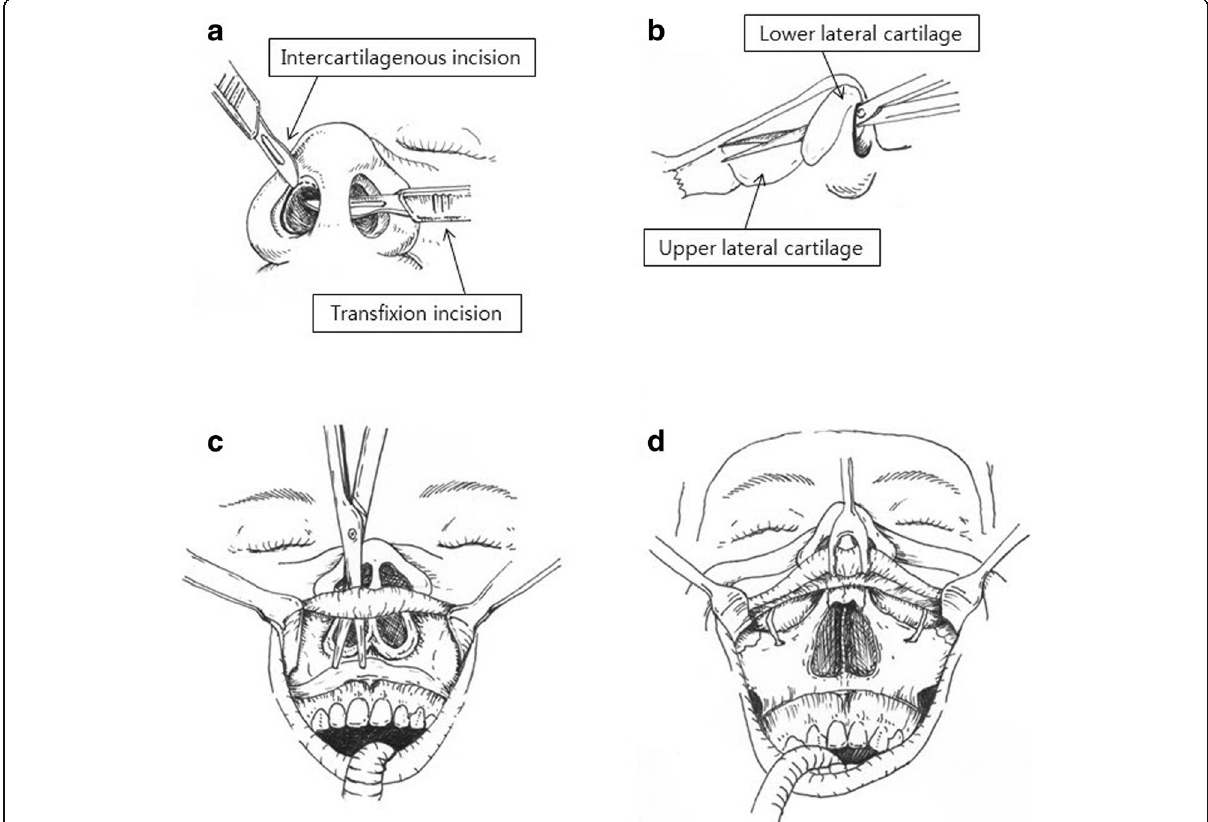
Fig. 4 Schema of the midfacial degloving approach. a The intercartilaginous incision (between the upper and lower lateral cartilage) and the transfixion incision (anterior of the nasal septum). b Undermining with the scissor at the outer surface of the upper lateral cartilage. c Connection of the intranasal incisions and the oral incision. d Facial degloving to expose entire midface